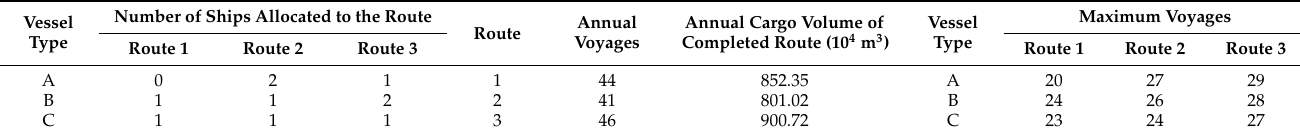
Table 6. The optimal fleet deployment and voyage frequency of the